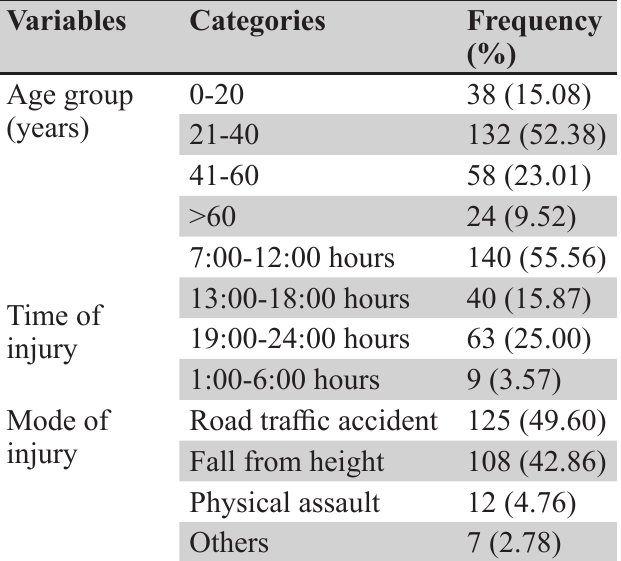
Table 1. Demographic profile of head